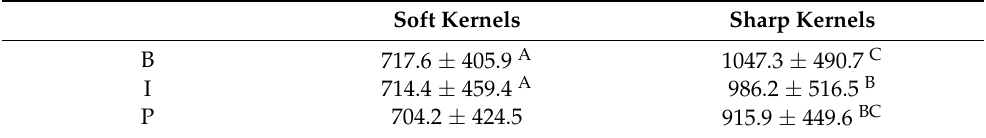
Table 2. Results of the stone CT-value measurements and statistical analysis. Stone CT values of the three evaluated reconstructions were compared (B vs. I, I vs. P, P vs. B). Differences between CT values with shared superscripts were statistically